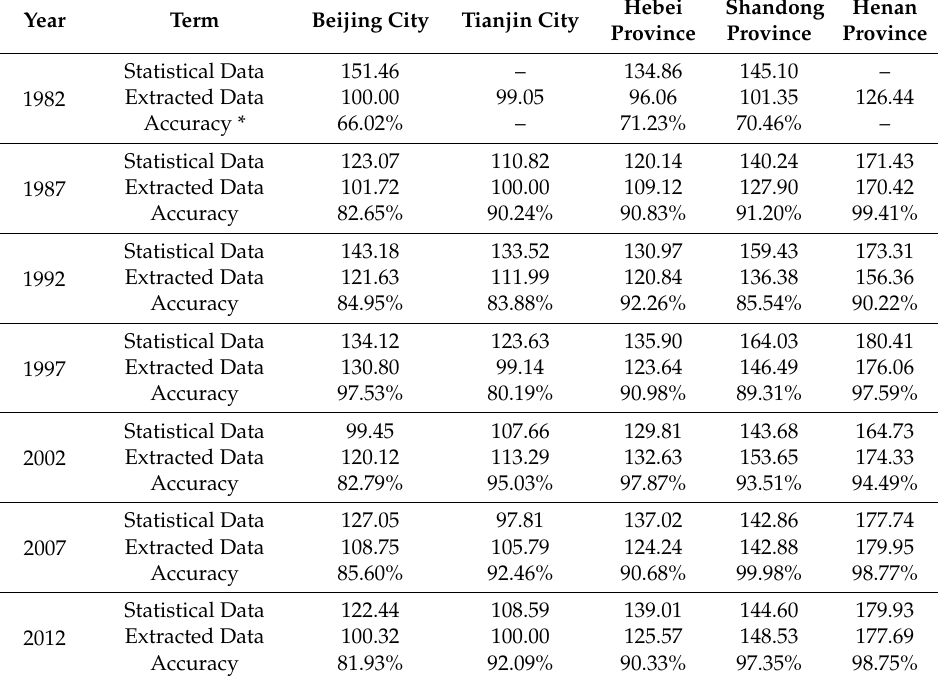
Table 2. Comparison between Multiple Cropping Indices extracted from remote sensing data and statistics in the North China Plain from 1982 to